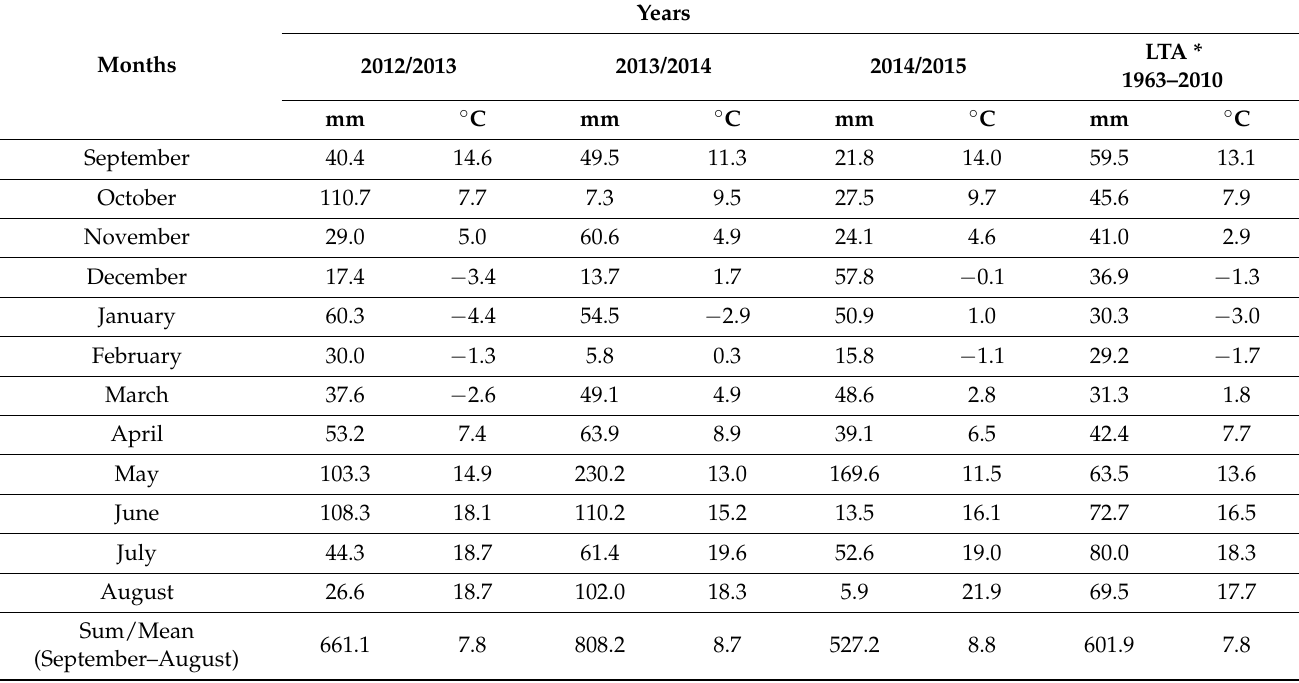
Table 2. The rainfall and mean monthly air temperature in the growing season of spelt wheat, according to the Meteorological Station in Czesławice